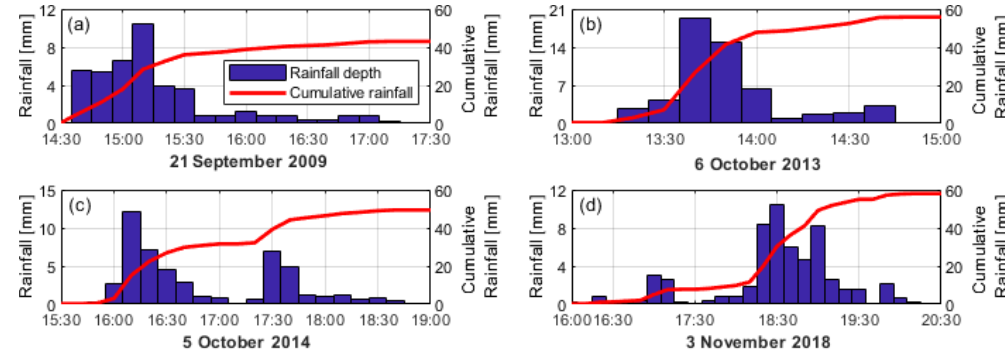
Figure 5. Rainfall collected at the Uditore rain gauge for the events occurring on (a) 21 September 2009, (b) 6 October 2013, (c) 5 Octo- ber 2014, and (d) 3 November